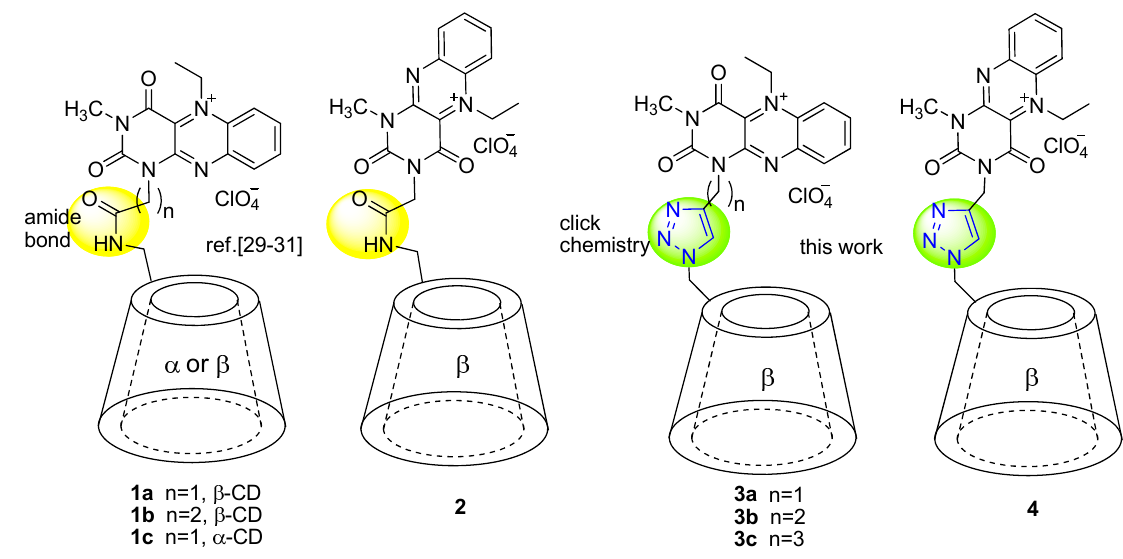
Figure 1. Design of flavin-cyclodextrin conjugates.